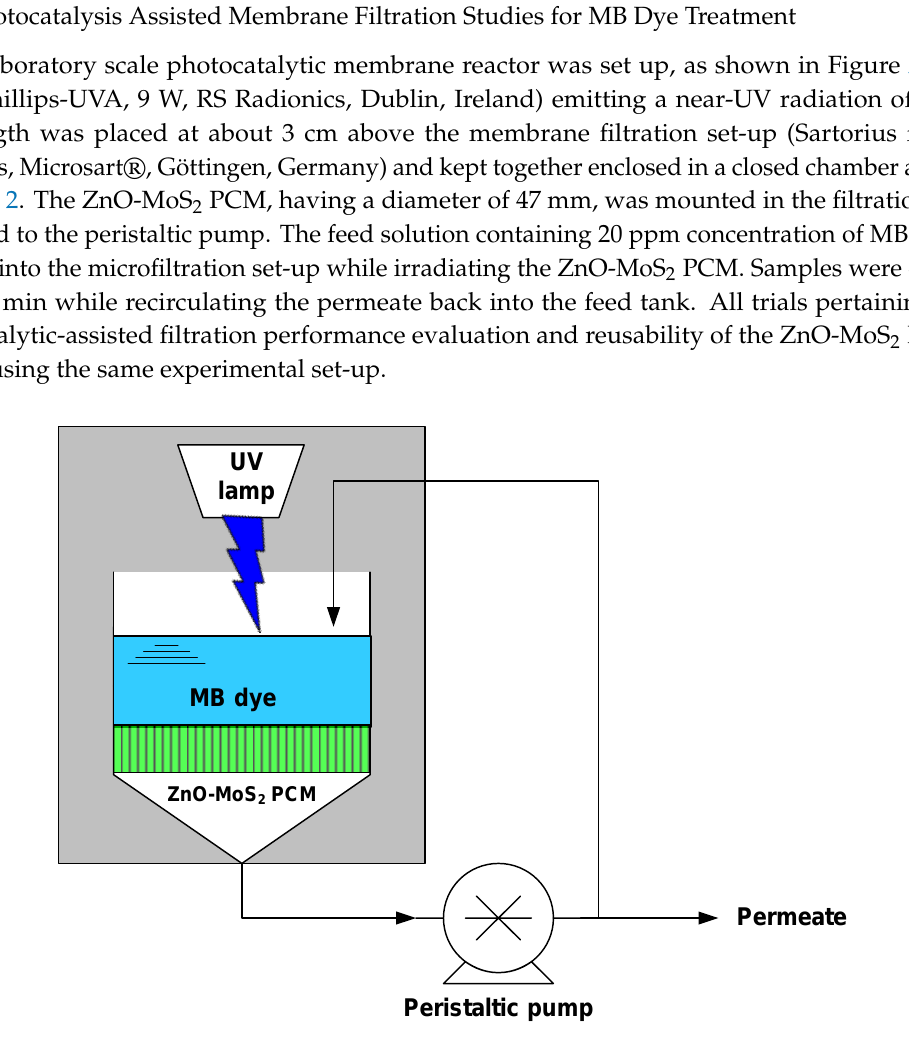
Figure 2. Schematic representation of UV-assisted membrane filtration set-up for the MB dye treatment.